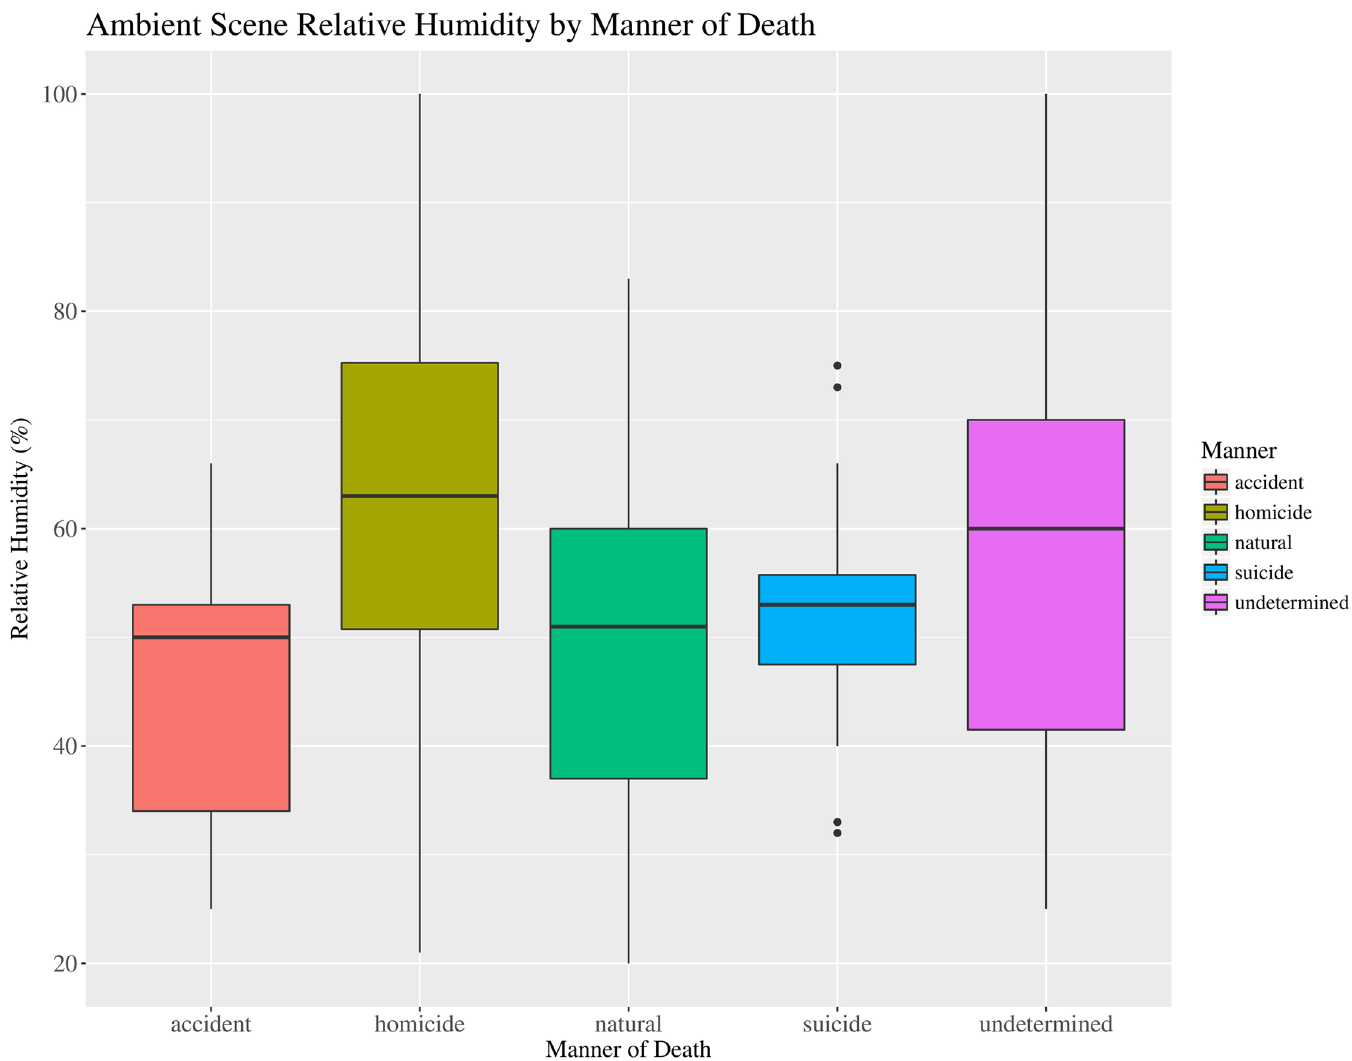
Fig 4. Boxplot of median relative humidity (%) by manner of death. Boxplot illustratingthe medianrelative humidity (%) and associatedvariation recorded near the decedentat scenes by the Mannerof death classification for forensic entomology cases over the study period(January2013–April 2016). (N =